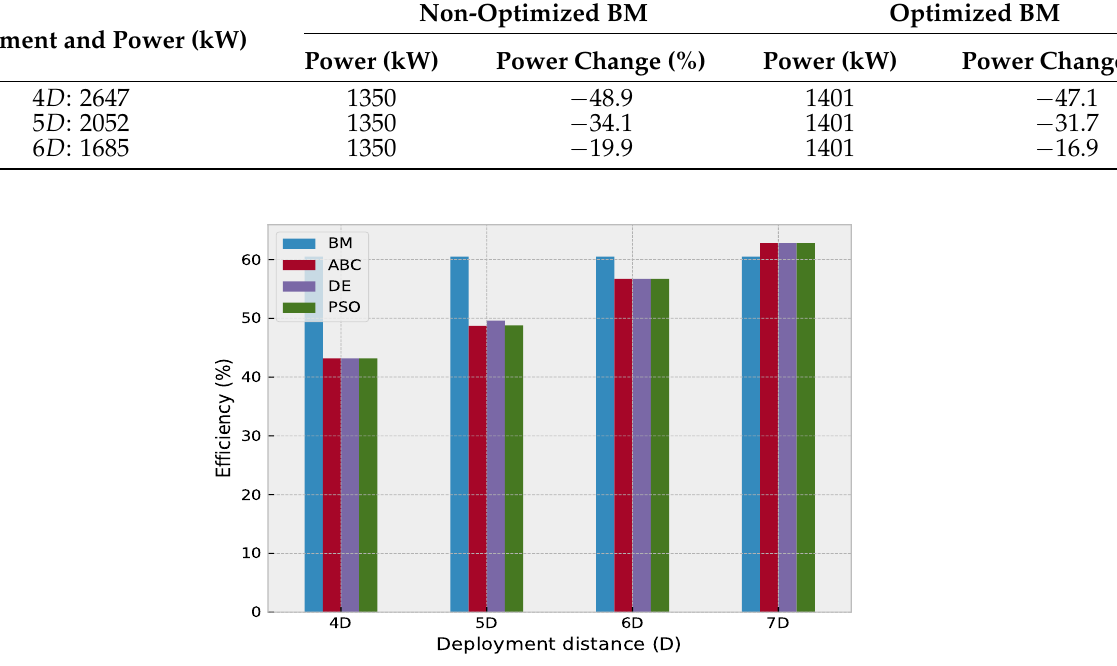
Figure 18. Plant efficiency variation for a 7 m/s